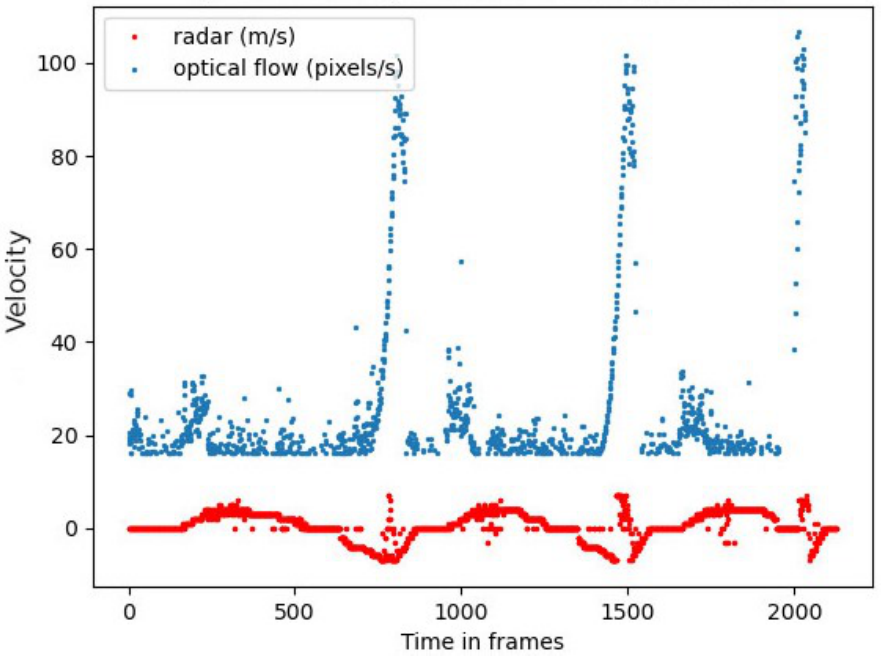
Figure 3. Plot of optical flow values overlapped with radar speeds against time in frames. High peaks of optical flow depict the car’s motion towards the apparatus and the low peaks depict the reversing. It is clear that optical flow is very sensitive to car